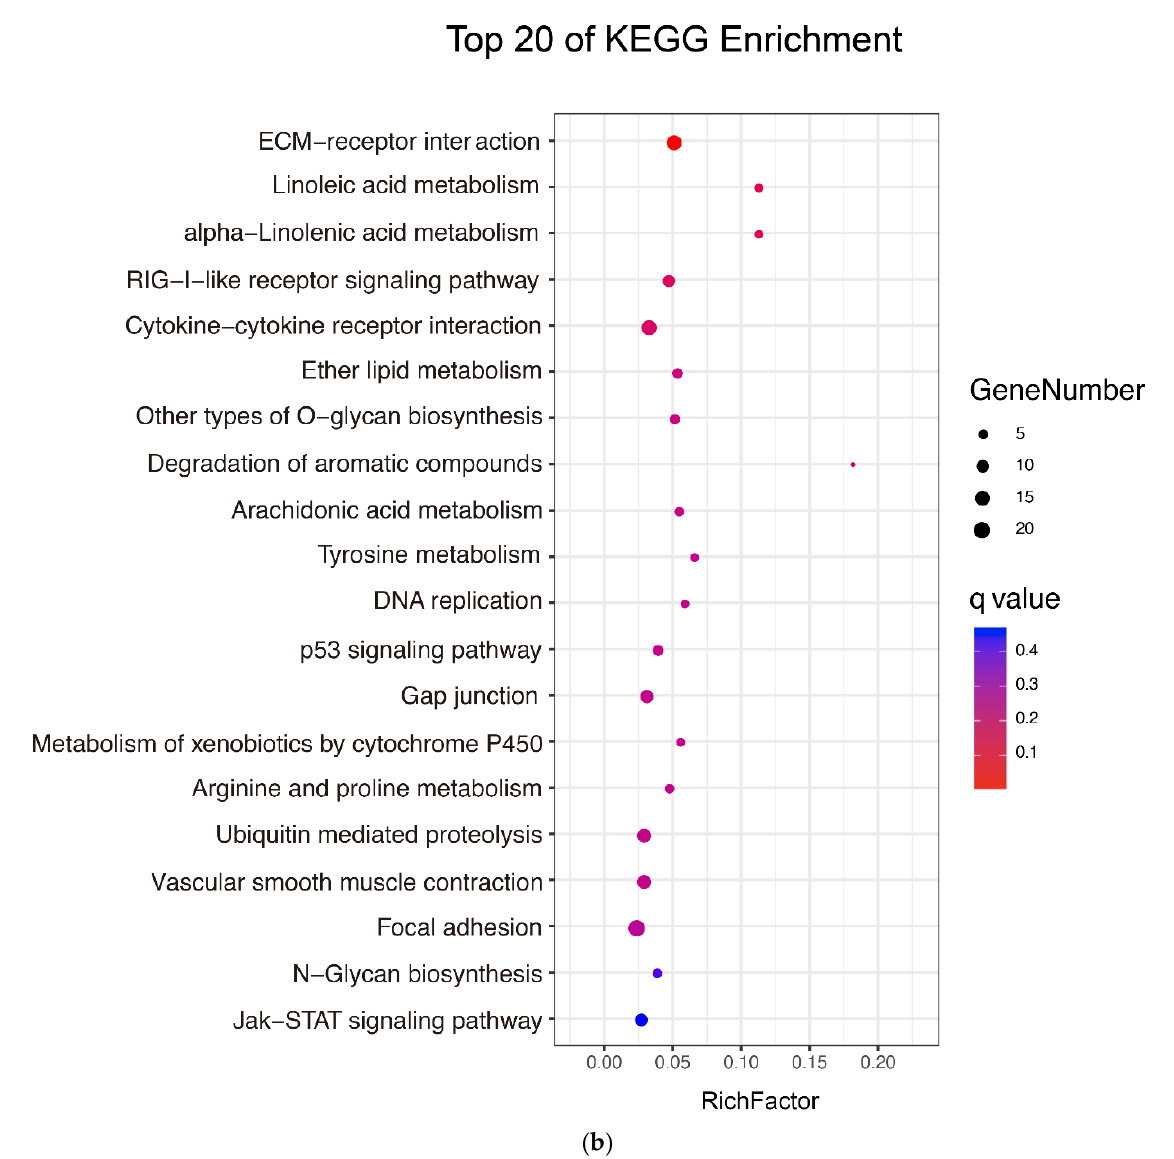
Figure 4. Functional enrichment of the differentially expressed target genes of DEmiRs (DETmRs). ( a ) DETmRs enriched in Gene Ontology (GO) terms; ( b ) The top 20 enriched Kyoto Encyclopedia of Genes and Genomes (KEGG) pathways of the DETmRs.